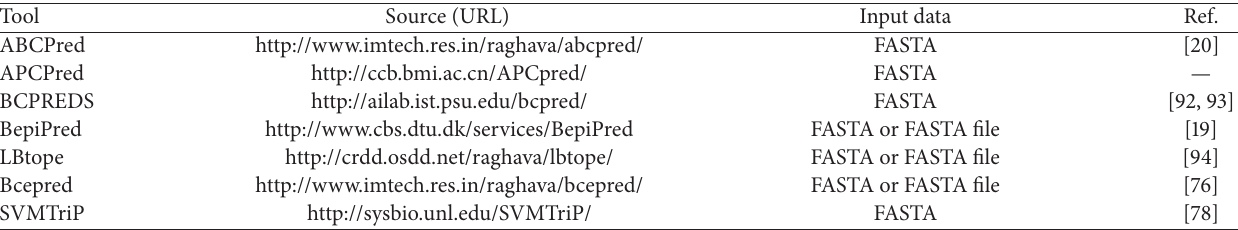
Table 2: List of web available tools for continuous B-cell epitope prediction.